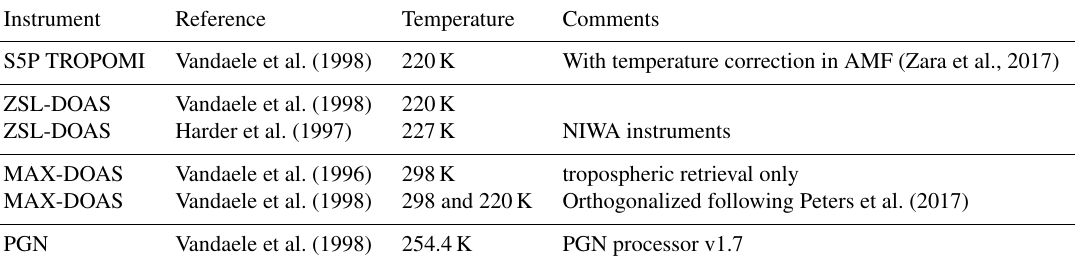
Table 3. NO 2 cross section source and temperature for the different data processing used in this work. More detail is provided in Sect. 2.5.